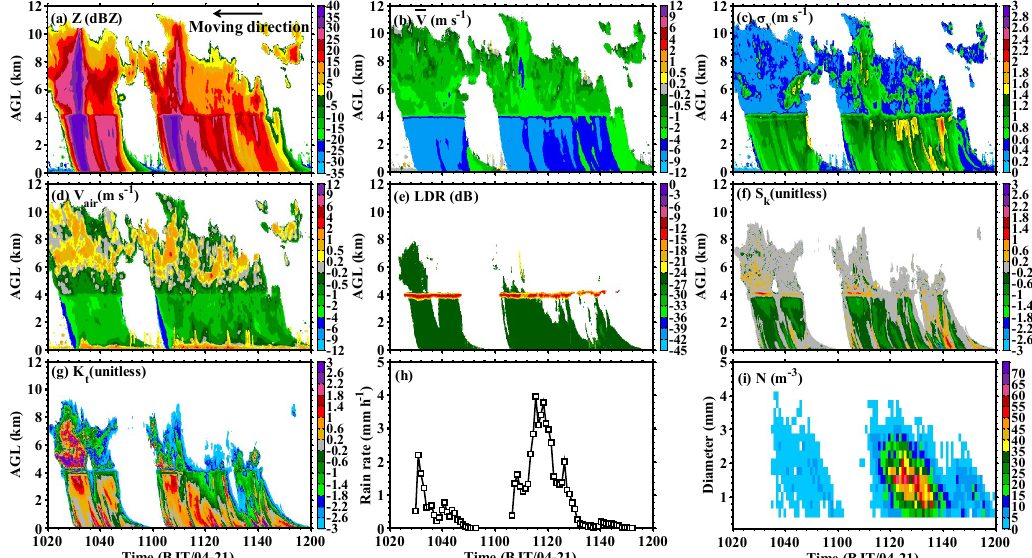
Figure 5. Time–height cross-sections of the MMCR measurements and Parsivel-measured rain rate and DSD for a nonlinear multi-cell convection that occurred over the site between 10:20–12:00 BJT on 21 April. ( a )–( g ) are radar reflectivity, mean Doppler velocity, spectrum width, vertical air velocity, linear depolarization ratio, spectral skewness, and spectral kurtosis; ( h ) and ( i ) are ground rain rate and drop size distribution.